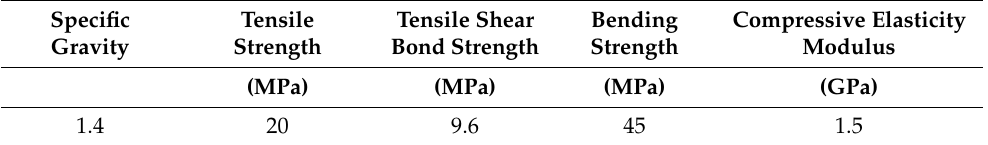
Table 4. Properties of the epoxy